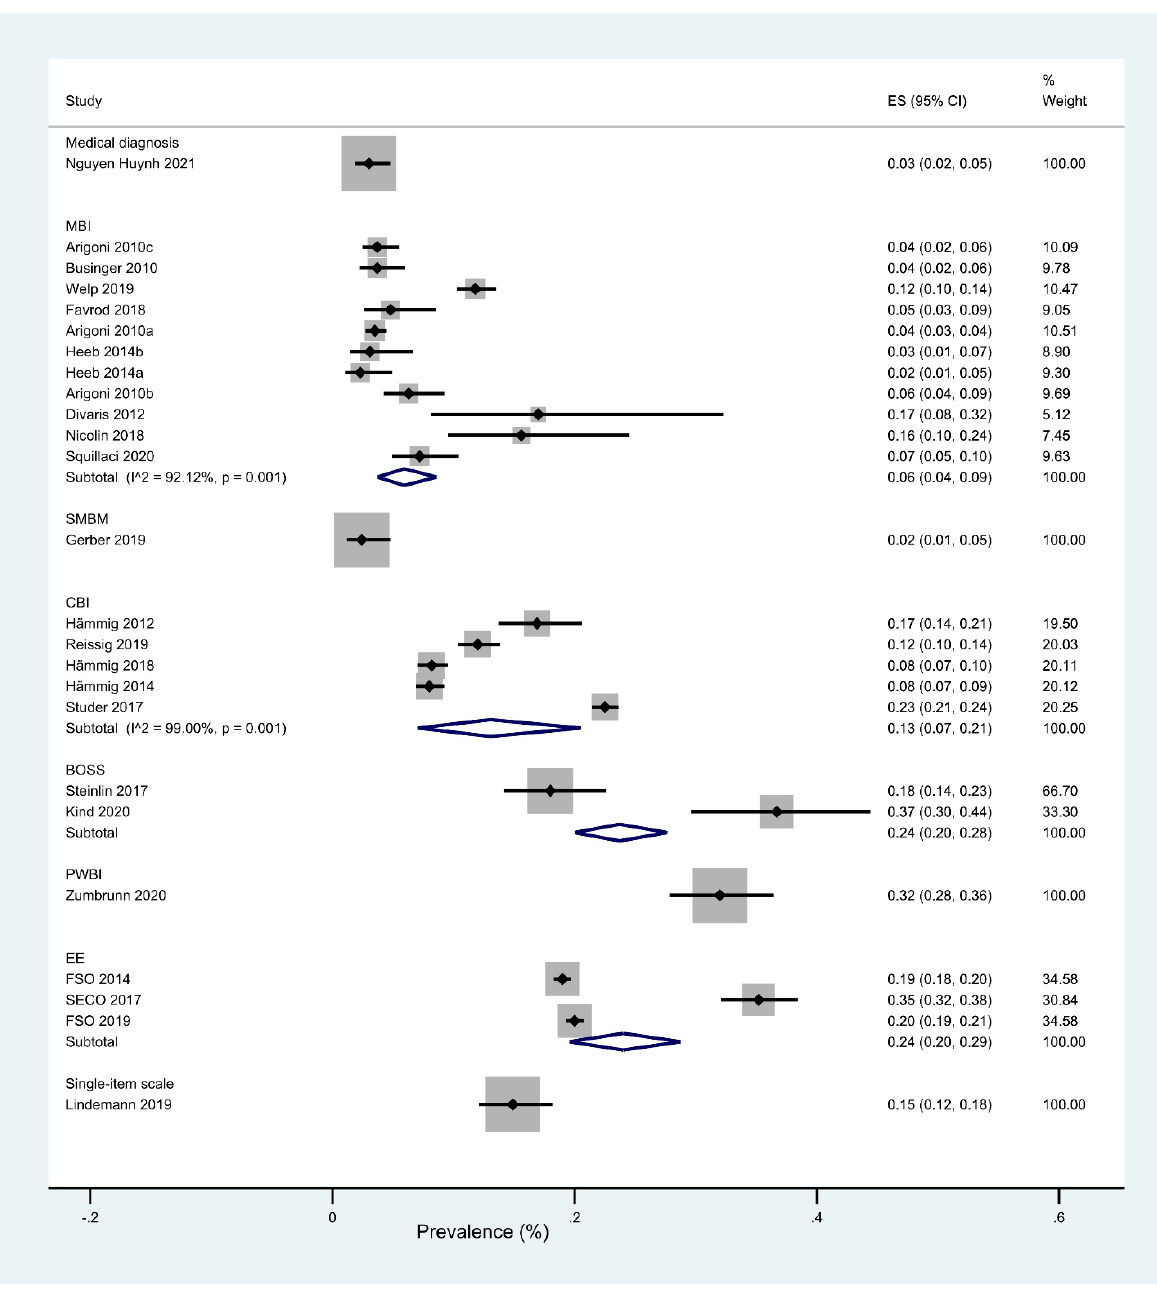
Figure S1. Burnout prevalence rates per scale or measurement